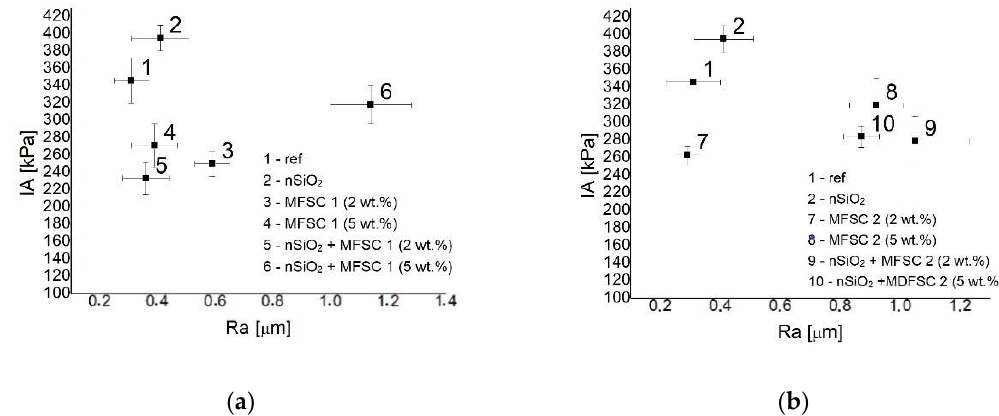
Figure 6. Relationship of IA (ice adhesion) as a function of R a for samples modified with ( a ) MFSC 1 and ( b ) MFSC 2.